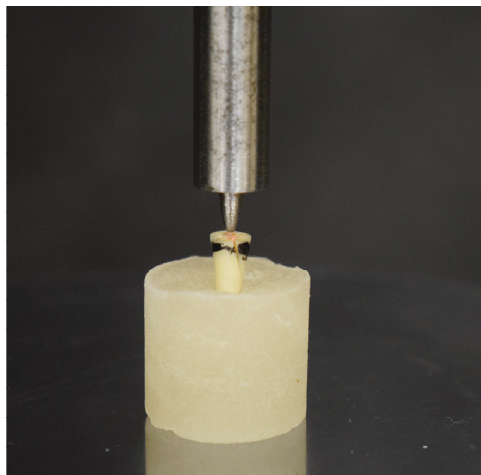
Figure 4. Representative sample mounted on universal testing machine for vertical root fracture test. The “fracture moment” was identified as the time when there was a dramatic drop in force, as shown on the testing machine display. In most samples, the fracture period was accompanied by an audible sound. Data were recorded using computer software (Instron ® Bluehill Lite Software), and the maximum force necessary to fracture each specimen was recorded in Newtons